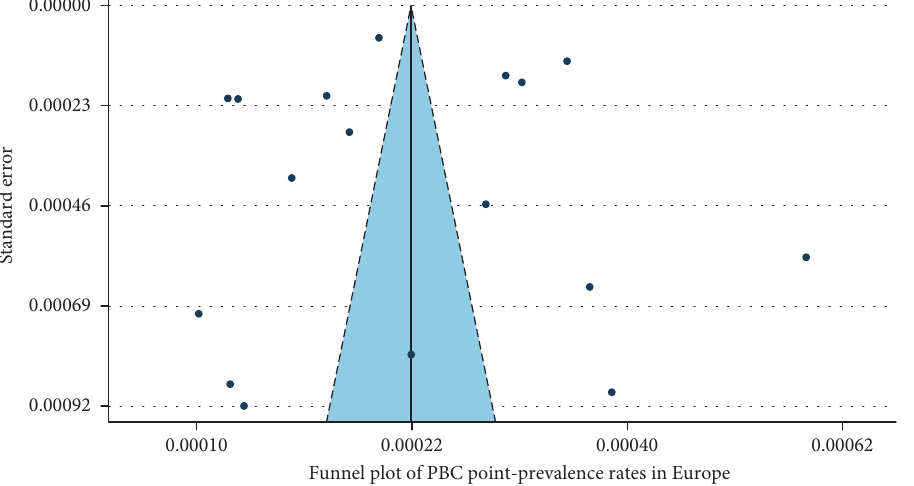
Figure 4: Funnel plot of PBC point-prevalence rates in Europe.